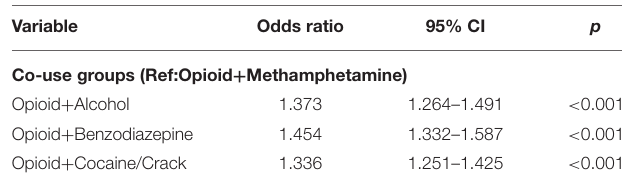
TABLE 2 | Logistic regression model predicting treatment completion by co-use